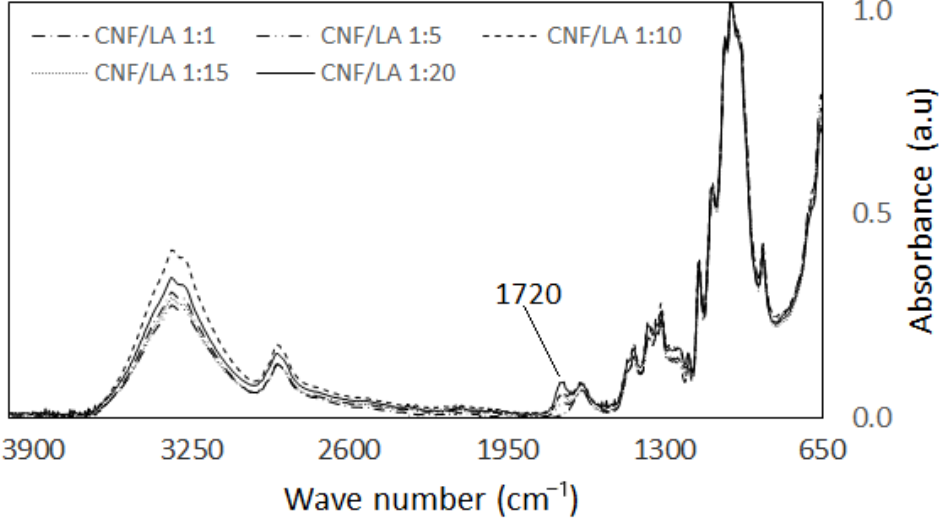
Figure 3. Schematic of lactic acid reacting with one hydroxyl group on the CNF surface through esterification, resulting in lactic acid-grafted CNF.